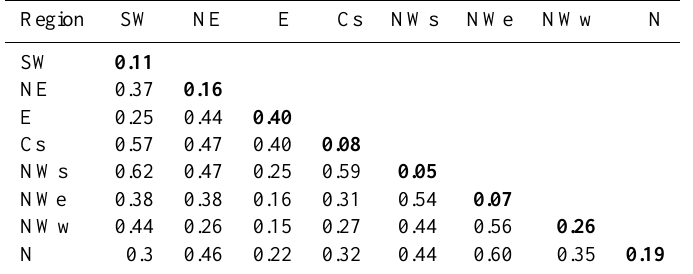
Table 2. Daily co-occurrence of EHDs between pairs of regions. Non-diagonal elements indicate the probabilities of having a simultaneous EHD between all possible pairs of regions. Diagonal (bold values) indicates the probabilities of having an EHD exclusively over a given region. Region SW NE E Cs NWs NWe NWw